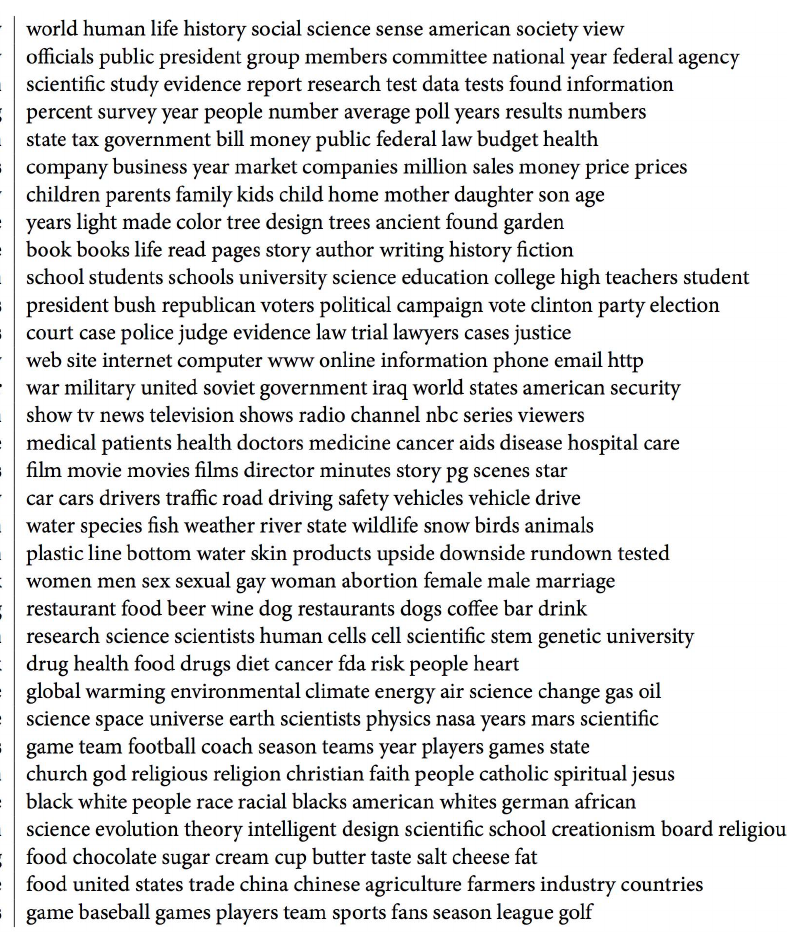
Figure 3. Labeled substantive topics. Ten most likely words for each topic listed to right of assigned topic label. Asterisks indicate subjects previously identified in qualitative case studies of demarcation.